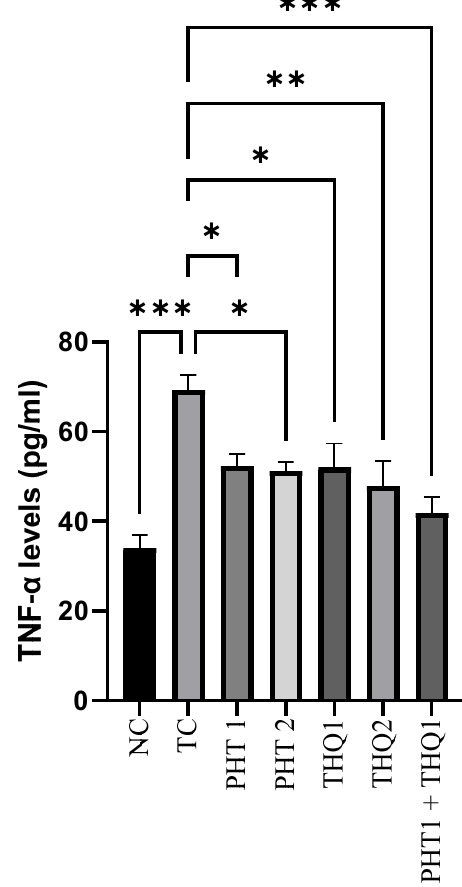
Figure 6. Effect of PHT (20 and 40 mg/kg), THQ (40 and 80 mg/kg) and PHT (20 mg/kg) + THQ (40 mg/kg) on hippocampal TNF- α levels following MES-induced convulsions in rats. One-way ANOVA followed by Dunnet’s test was used to compare quantitative variables from the toxic control vs. other groups. PHT, THQ, TC and MES indicate phenytoin, thymoquinone, toxic control and maximal electric shock, respectively. * p < 0.05, ** p < 0.01, *** p < 0.001